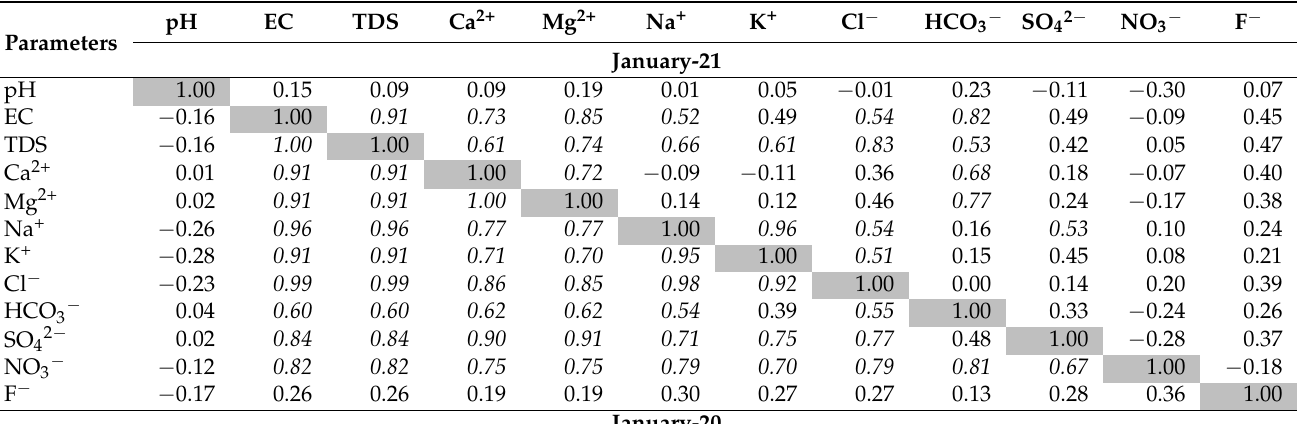
Table 4. Groundwater chemistry in a Pearson correlation